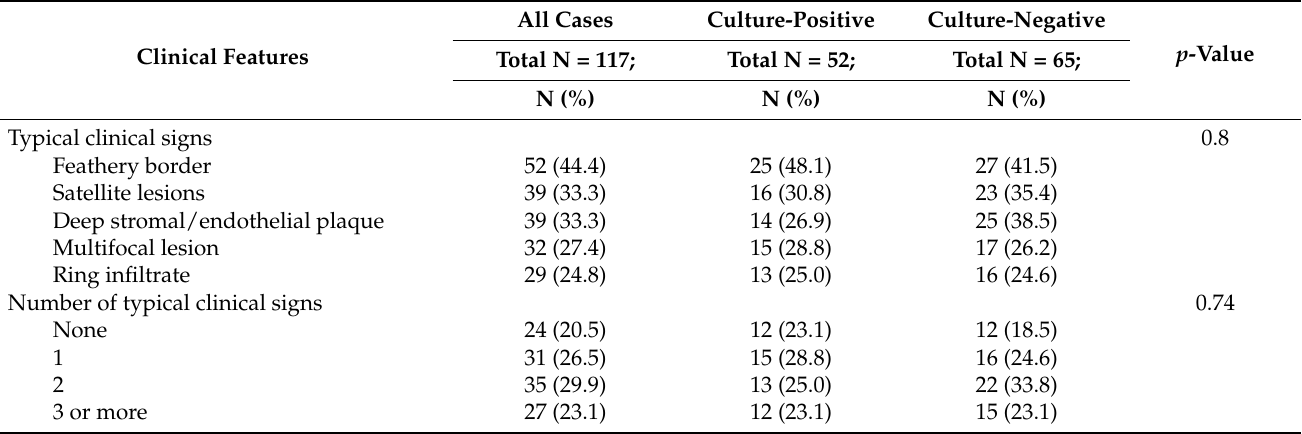
Table 4. Typical clinical signs of culture-positive and culture-negative fungal